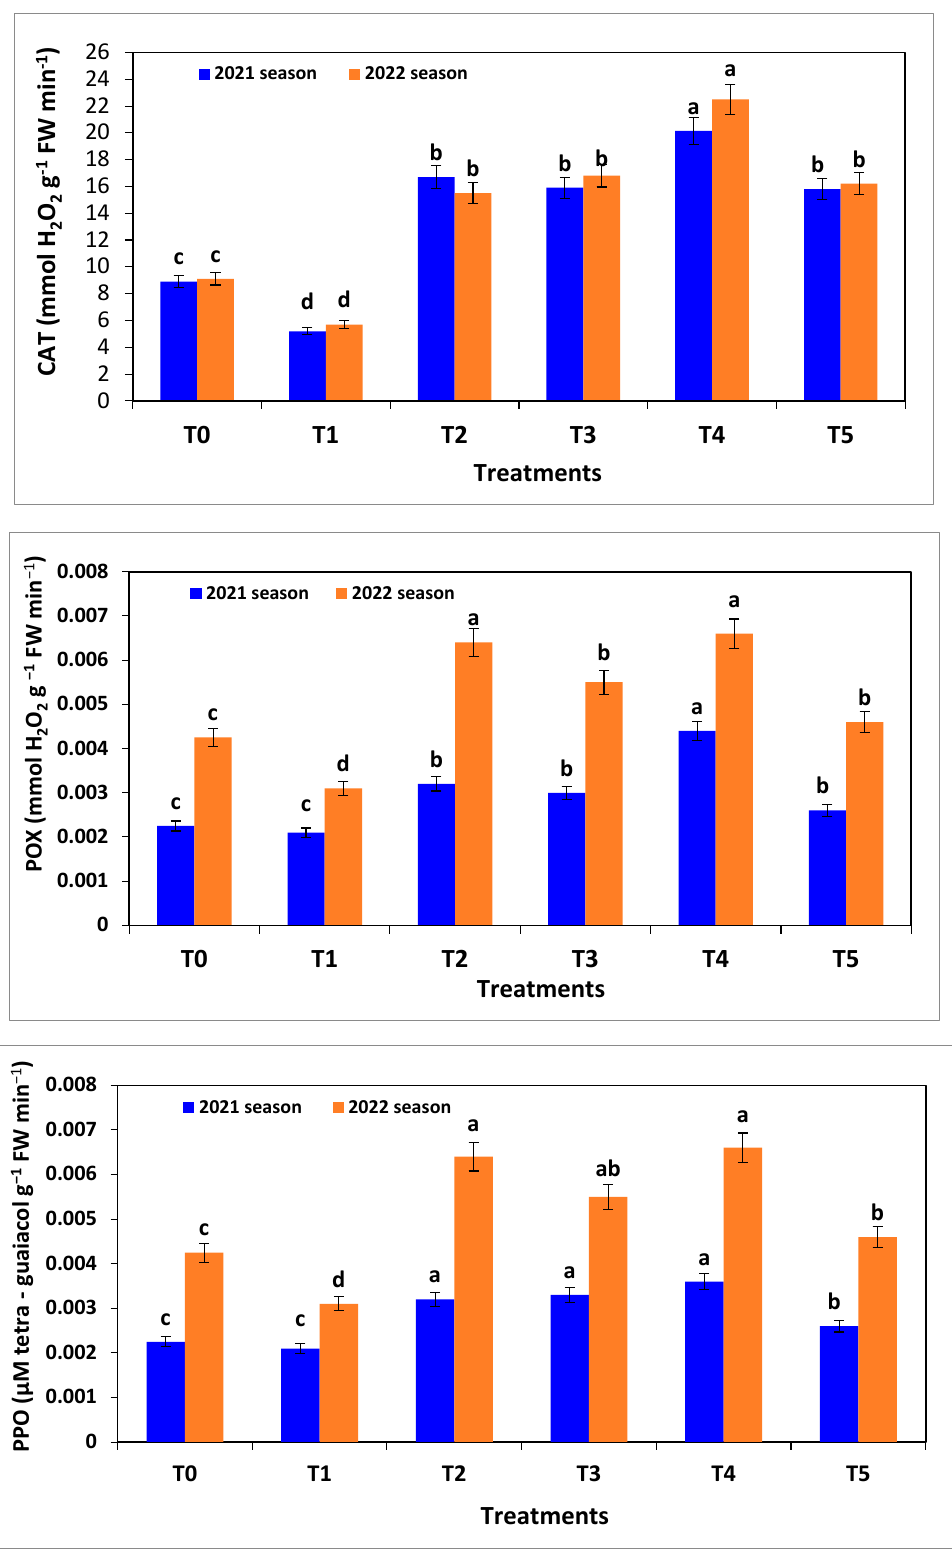
Figure 7. Effects of different treatments on enzymatic antioxidants in tomato seedlings including catalase (CAT), peroxidases (POX) and polyphenol oxidase activity (PPO), which were measured after 30 days from applying treatments. For more details about treatments please refer to Table 1. Values of means in each column followed by the same letter are not significant at p < 0.05.